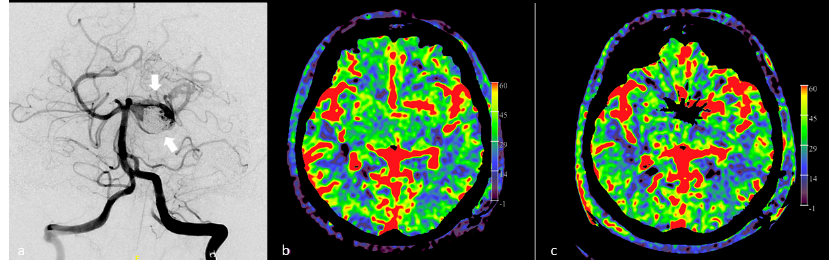
Figure 7. Intraprocedural FD CT PBV imaging in a case of PVO due to insufficiently treated dissecting P1–P2 aneurysm by stent assisted coiling. ( a ) DSA in AP view demonstrates the partially coiled dissecting aneurysm (white arrows). ( b ) Pre PVO FD CT PBV mapping demonstrates symmetric PBV maps. ( c ) Post PVO FD axial CT PBV MIP reformation shows no asymmetry in PBV values, suggesting the patient’s toleration to the PVO.